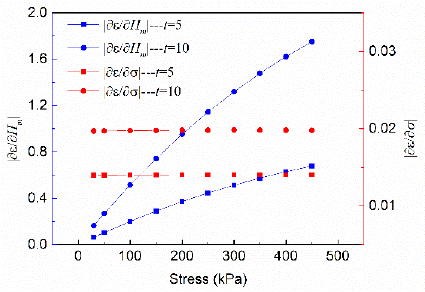
Figure 11. Model sensitivity analysis.